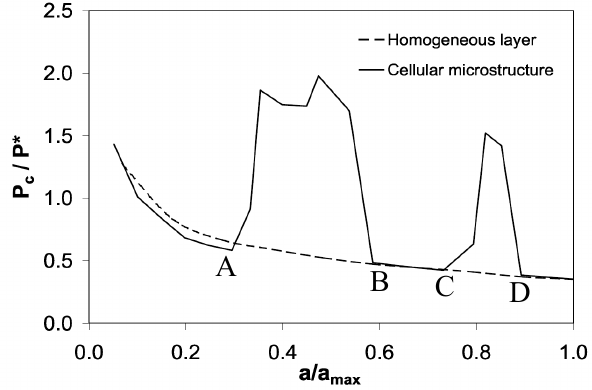
Figure 8. Dimensionless critical load for brittle crack propagation vs. dimensionless crack length. The response of a cellular microstructure is compared with that of a homogeneous layer.